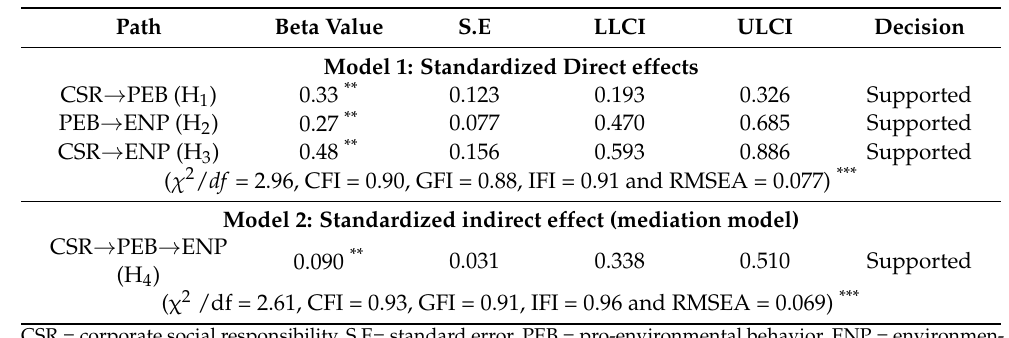
Table 3. Hypotheses testing.